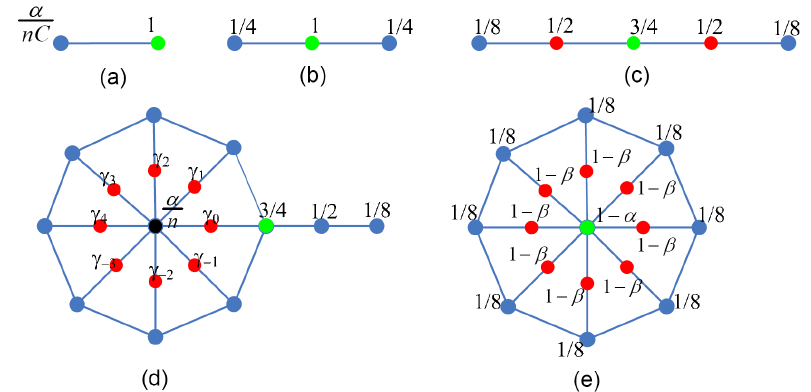
Figure 5. Discrete subdivision masks of basis functions in radial layers (lazy wavelets and scaling